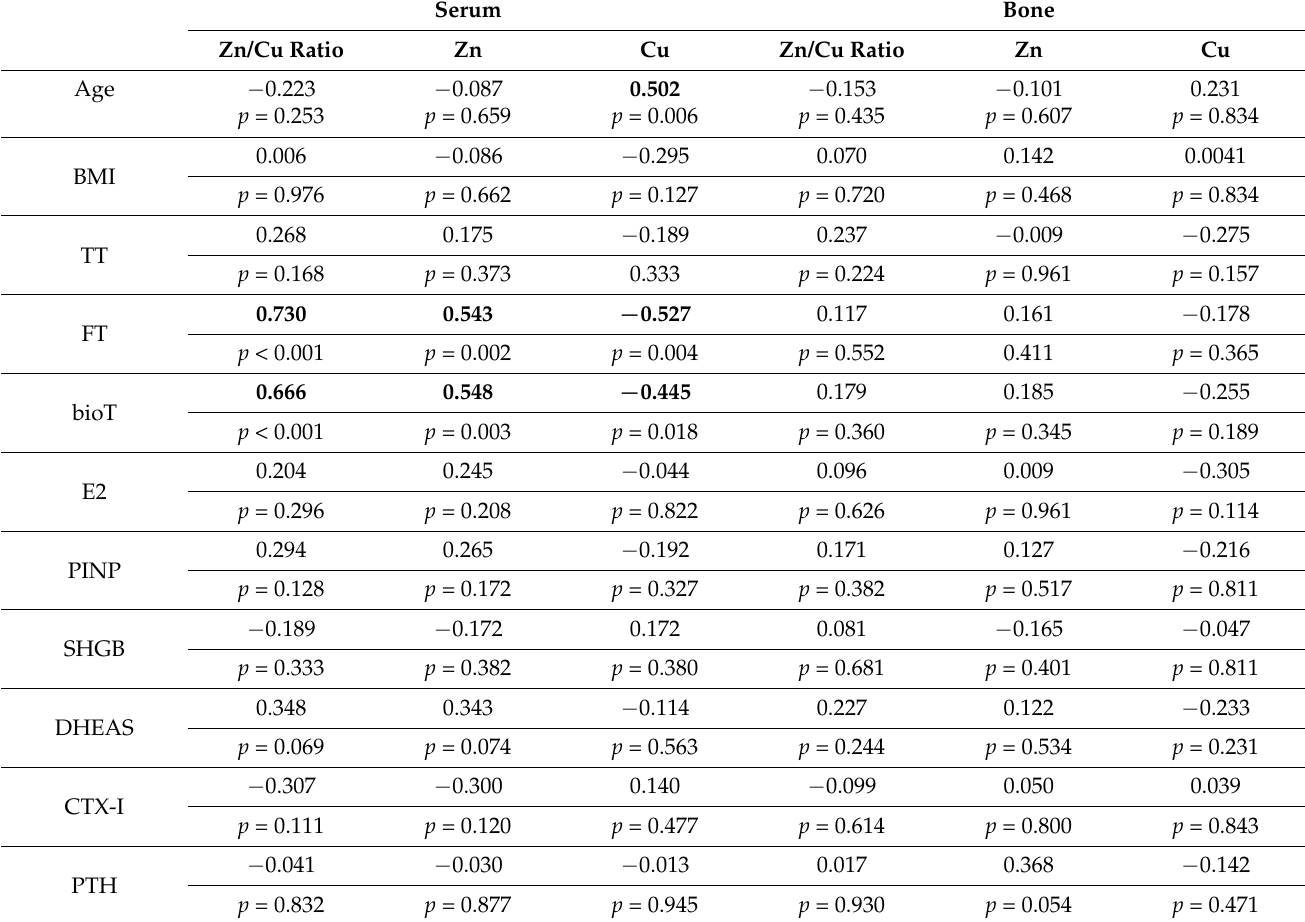
Table 3. Correlations of Zn and Cu with age, BMI, sex hormones, bone turnover markers, and densitometric